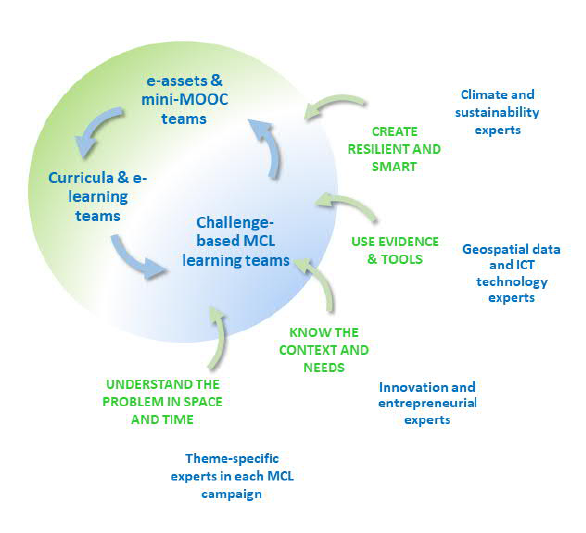
Figure 3. GeoICT4e experts work in thematic teams, which consists of experts from multiple universities and from the innovation